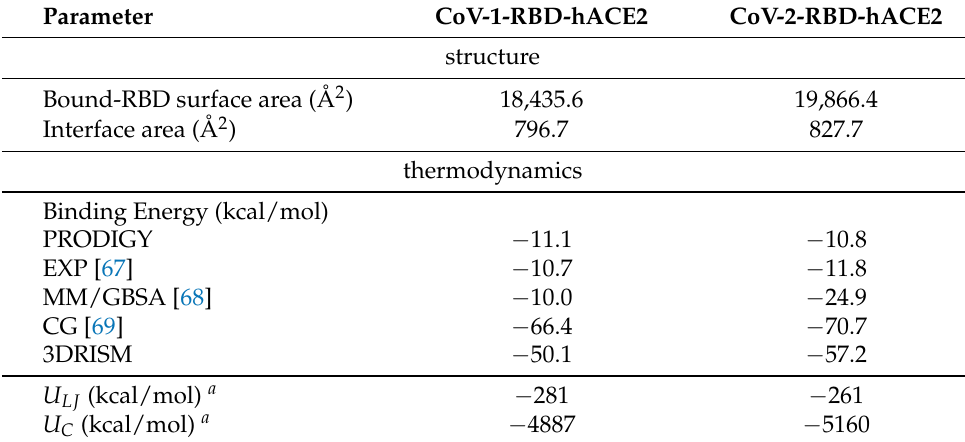
Table 1. Interface properties of RBD-hACE2 complexes for CoV-1 and CoV-2.